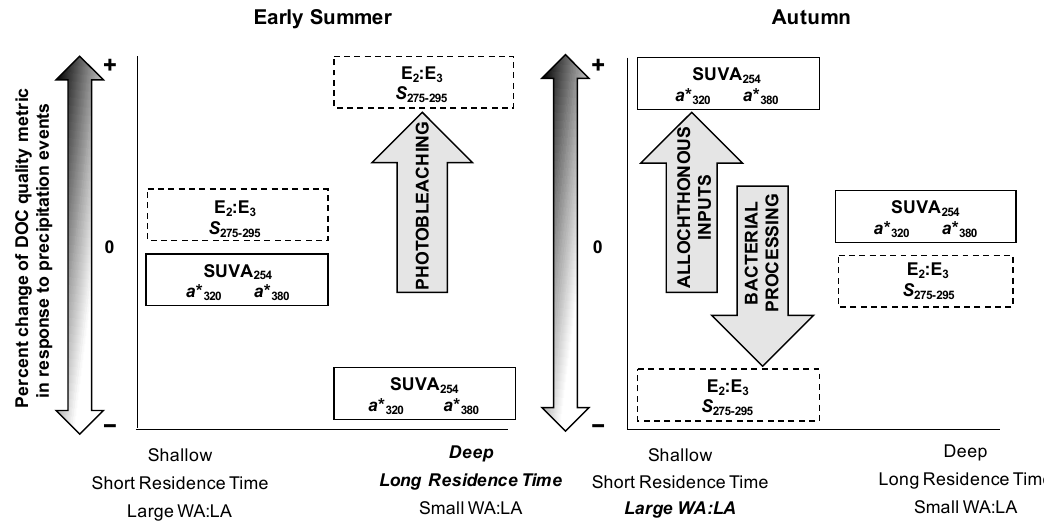
Figure 7. Conceptual figure of the dominant processes contributing to changes in DOC quality metrics for the Early Summer and Autumn storms. All responses are indicated by the percent change in DOC quality to a precipitation event, and the lake characteristics that influence a particular response. E 2 : E 3 and S 275–295 are indicated by dashed boxes and SUVA 254 , a * 320 , and a * 380 are indicated by solid boxes. Gray arrows indicate dominant processes that contribute to DOC quality response and bold italics indicate key lake characteristics. SUVA 254 provides information on the source and biological availability of DOC, a * 320 is indicative of inputs of terrestrially derived DOC, a * 380 can indicated changes in color, E 2 : E 3 tracks changes in the relative size of DOC molecules, and S 275–295 is indicative of exposure to sunlight.